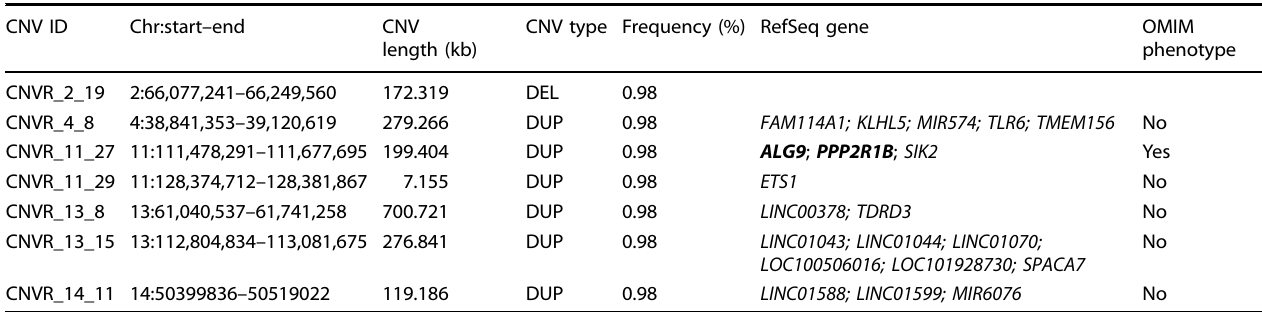
Table 1. Novel CNVs identi fi ed in the Tunisian population.